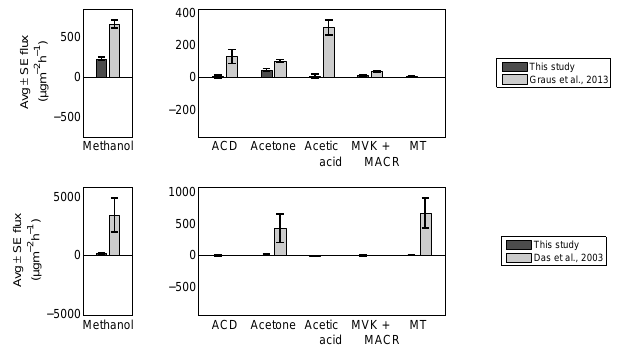
Figure 2. Comparison of BVOC exchanges at LTO with other maize studies. For comparison with Graus et al. (2013): R1 stage, 28 ◦ C ≤ T ◦ ≤ 32 ◦ C; PPFD ≥ 1000µmolm − 2 s − 1 . BVOC exchanges re- ported by Graus et al. (2013) were up-scaled with LAI measured at LTO during the R1 stage (4.86m 2 m − 2 ) . For comparison with Das et al. (2003): L and S stages, 24 ◦ C ≤ T ◦ ≤ 28 ◦ C, fluxes taken from 10:30 to 13:30UTC in order to capture midday fluxes. See Table 1 for compound abbreviations and Table 4 for maize studies description. Note the varying scales for the y axes.